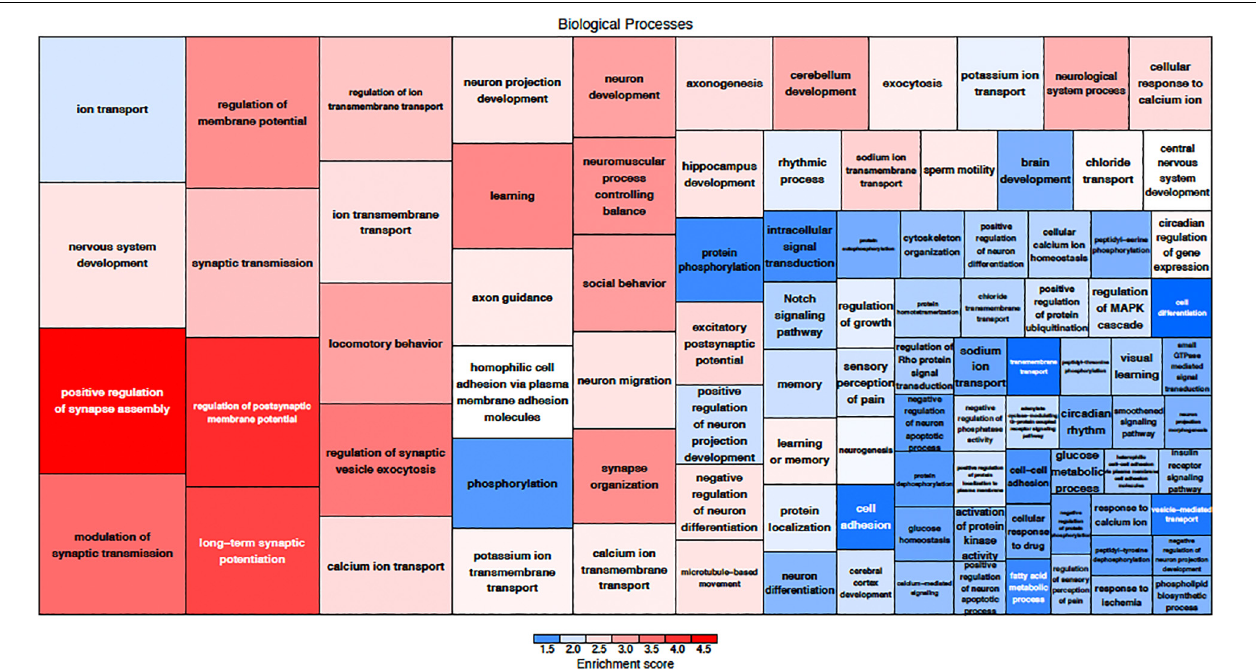
FIGURE 4 | Down-regulated biological processes classified by gene ontology. The size of the category corresponds to a lower FDR with the more deeply red groups representing a higher enrichment score. The graphic representation of gene expression demonstrates that a key element in MSC treatment is modulation of synaptic assembly which is represented in multiple groups of down-regulated